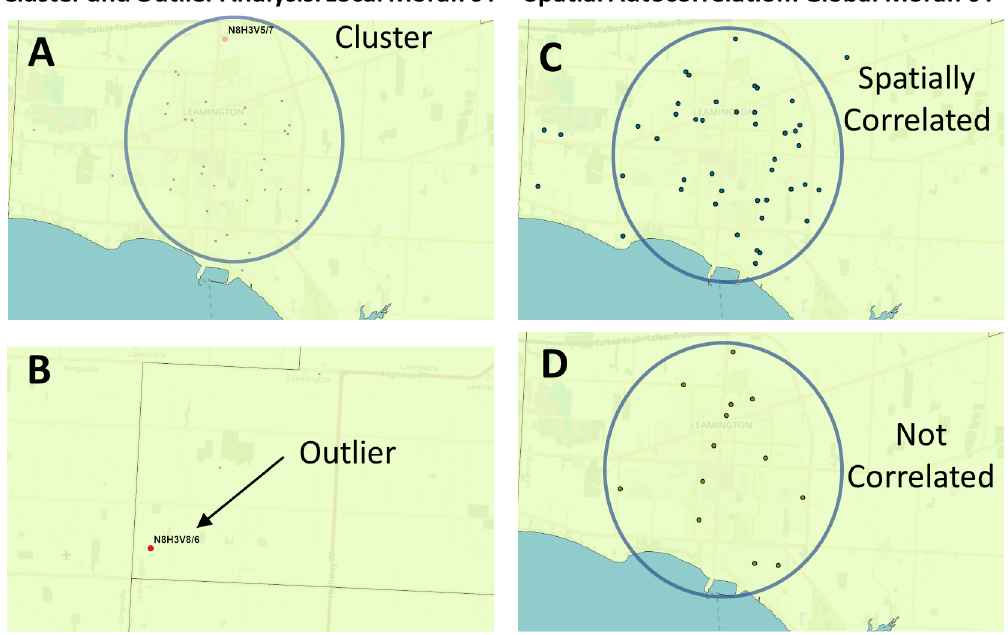
Figure 2. Geostatistical analysis of the distribution of COVID-19 cases. The Global and Local Moran ’ s I statistics determine whether the numbers of cases in different PCs or FSAs in a region are distinct from one another or are related. Local Moran ’ s I (also known as Cluster and Outlier analysis) computes a Moran ’ s I value, or spatial autocorrelation,betweencountswithinsetsofFSAsorPCs.GlobalMoran ’ sIevaluatestheoverallcaseclusteringina region. Panels shown indicate these relationships in Leamington FSA N8H: A) A positive local Moran ’ s I index indicates that the regions neighboring N8H 3V5 has similar attributes (a high-case cluster; pink dot). B) A negative local Moran ’ s I index demonstrates that cases the region surrounding the target aredissimilar (a high-case outlier in N8H3V8;reddot).C)TheGlobalMoran ’ sI(SpatialAutocorrelation) indexdemonstrateswhethercasesareclustered, dispersed, or randomly distributed. In this example, cases were significantly clustered from Dec. 21 to 23, 2020 (p = 0.03; p-value signifies whether the null hypothesis [a random distribution] can be rejected). D) The case distribution was not significantly clustered on Dec. 2 to 4, 2020 (p = 0.7).